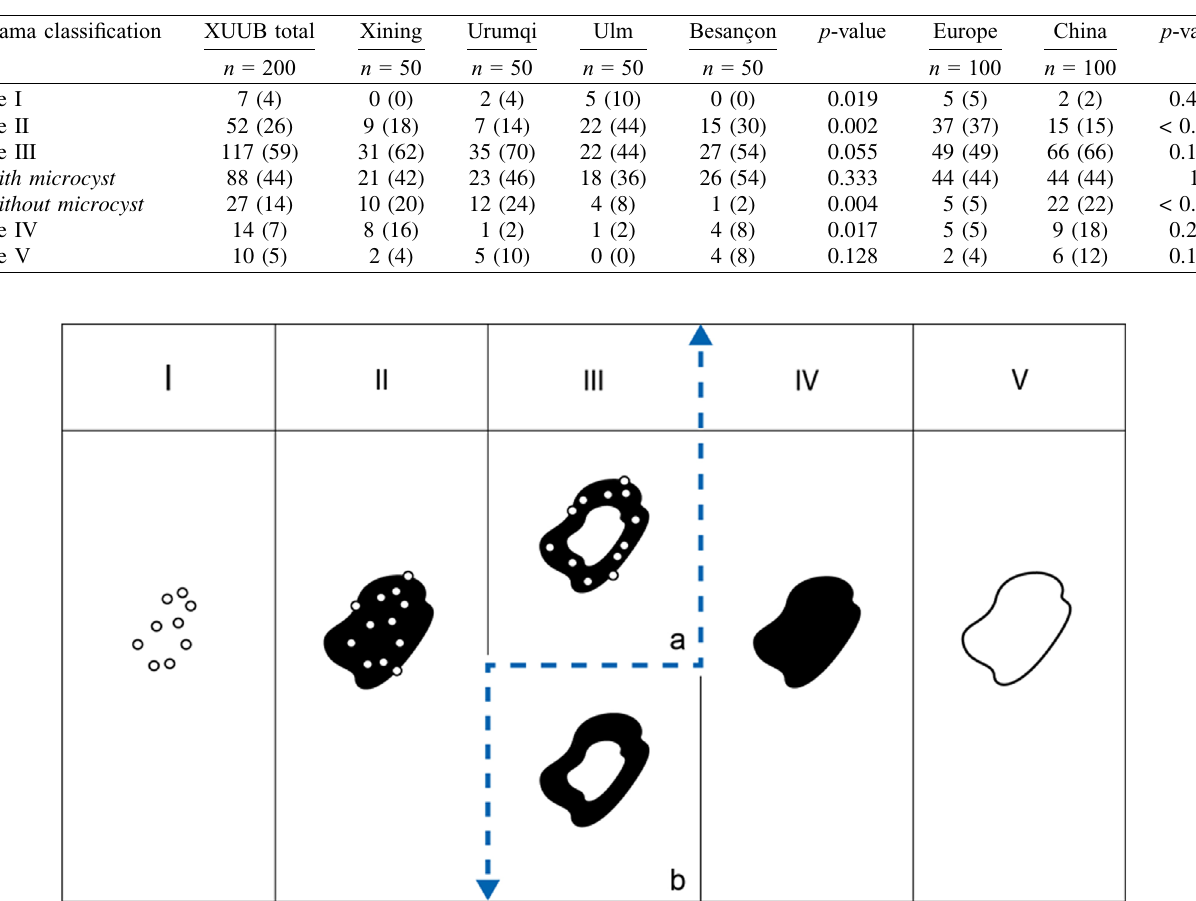
Figure 2. Table of the 5 types of AE lesions according to Kodama. The dashed line separates young, active lesions I, II and IIIa (left) from older, inactive lesions IIIb, IV and V